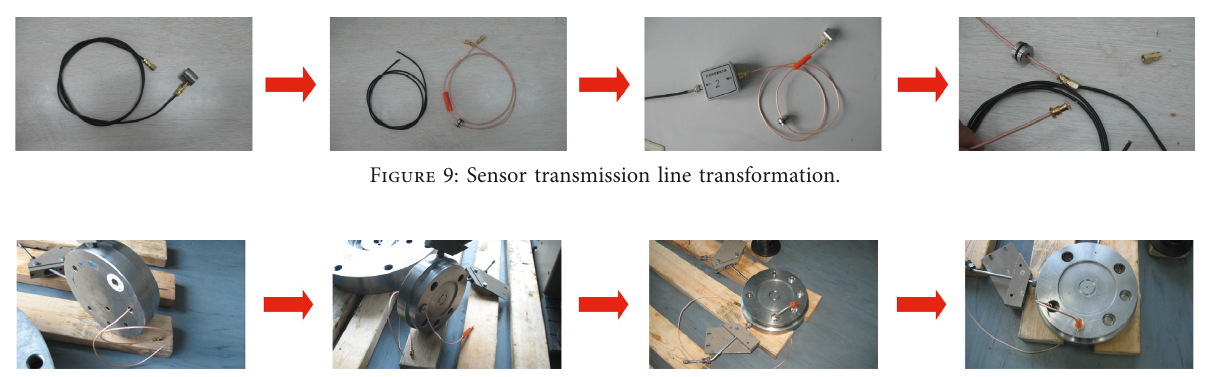
Figure 10: Communication hole